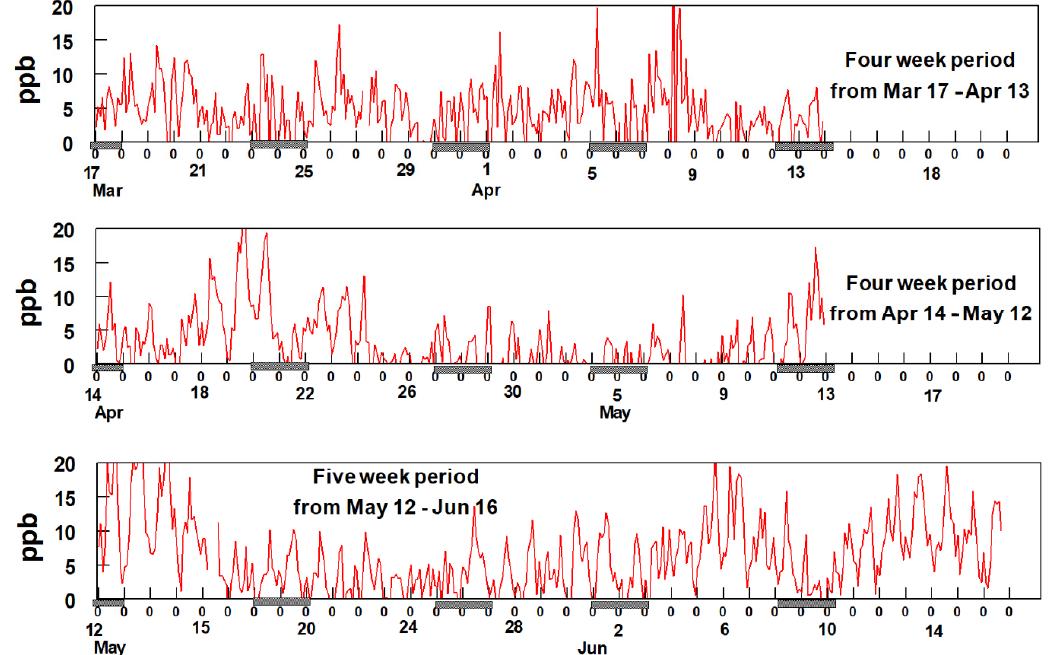
Figure 7. ( a ) shows two-hour average data for formaldehyde from 17th of March to 13th of April ( b ) 14th of April to 12th of May and ( c ) 12th of May till 16th of June. The hash marks under the x -axis indicates weekends.